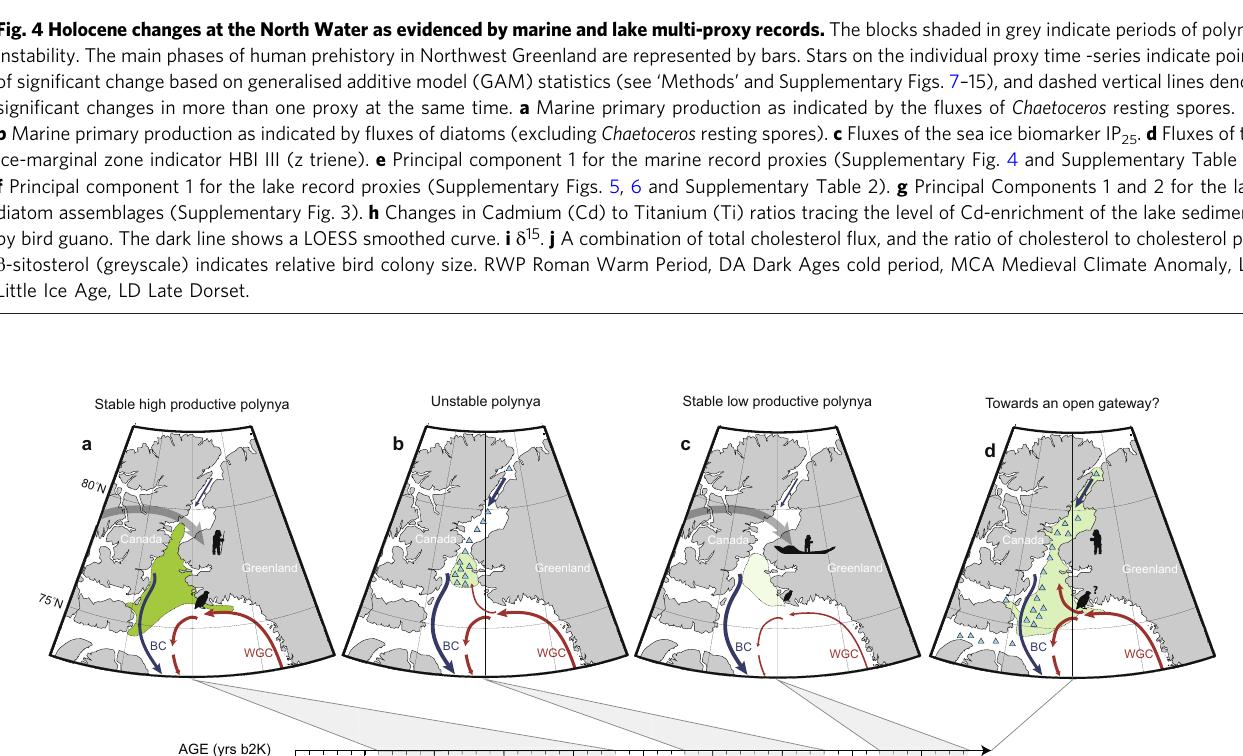
Fig. 4 Holocene changes at the North Water as evidenced by marine and lake multi-proxy records. The blocks shaded in grey indicate periods of polynya instability. The main phases of human prehistory in Northwest Greenland are represented by bars. Stars on the individual proxy time -series indicate points of signi fi cant change based on generalised additive model (GAM) statistics (see ‘ Methods ’ and Supplementary Figs. 7 – 15), and dashed vertical lines denote signi fi cant changes in more than one proxy at the same time. a Marine primary production as indicated by the fl uxes of Chaetoceros resting spores.